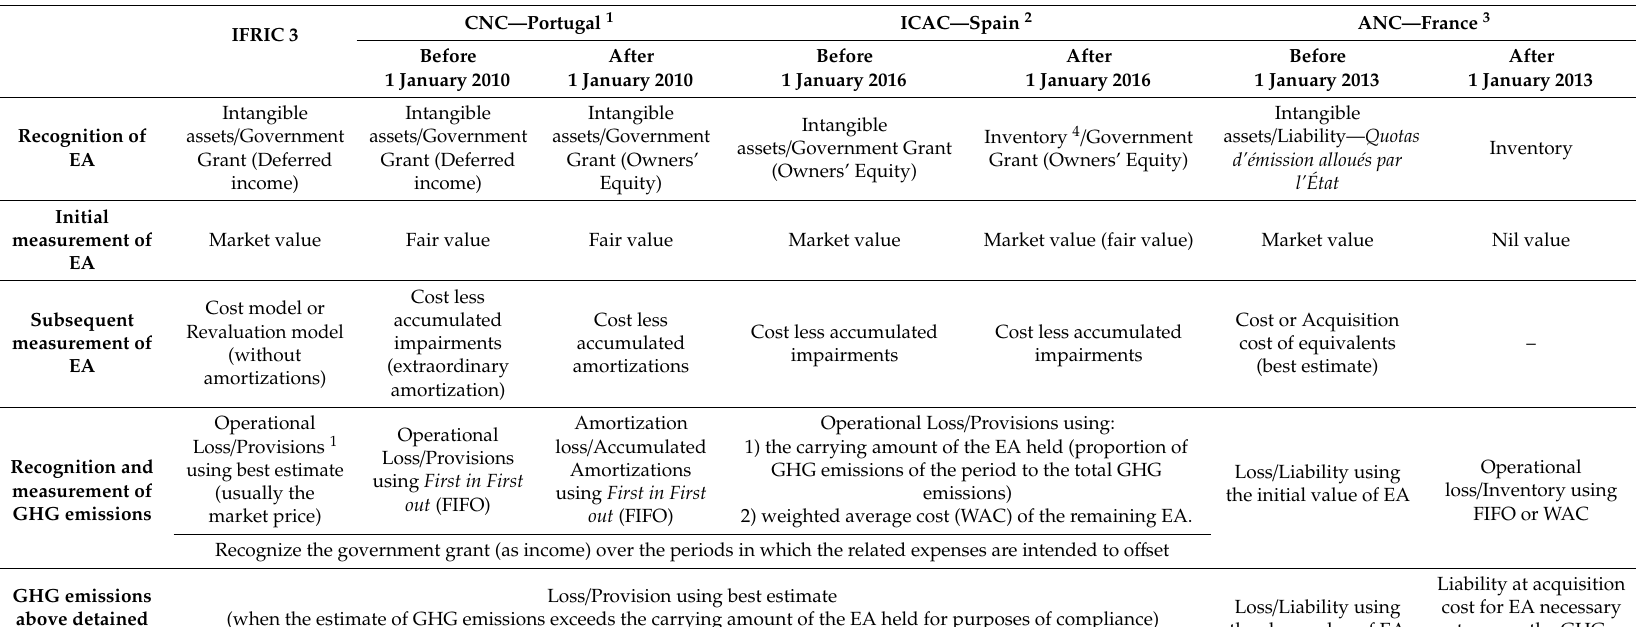
Table 1. Summary of Accounting Approaches for Emission Allowances (EA) and Greenhouse Gas (GHG)